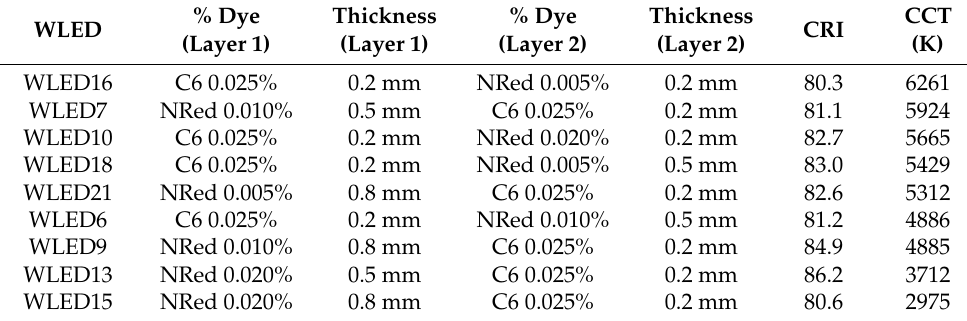
Table 3. A summary of best WLED devices (listed from higher CCT to lower CCT) along with their optical